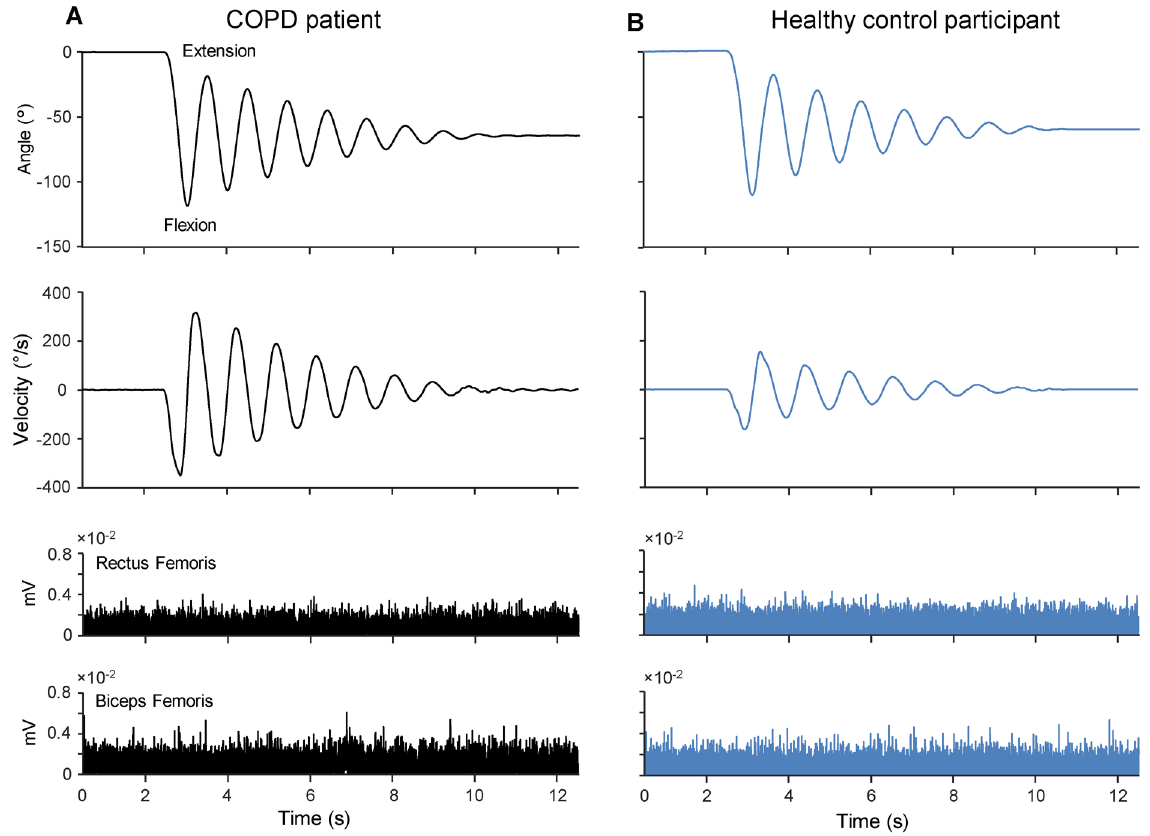
Figure 2. Representative examples of kinematic and electromyographic traces during pendulum test. Angular displacement, velocity, rectified EMG activity of Rectus Femoris and Biceps Femoris muscles, recorded in one patient with COPD ( A ) and one healthy control participant ( B